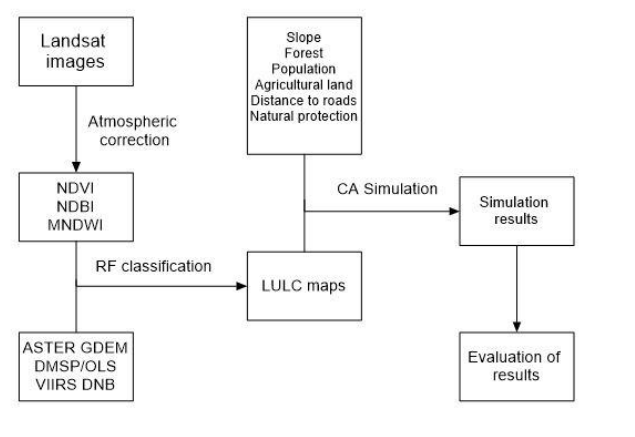
Figure 2. Flow-chart of